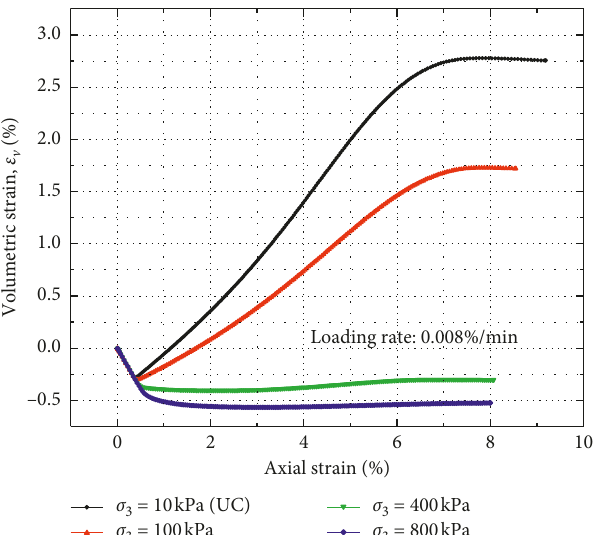
Figure 6: Volumetric strain (%) versus axial strain (%) for various confining stress for a single strain rate. Displacement control analysis is